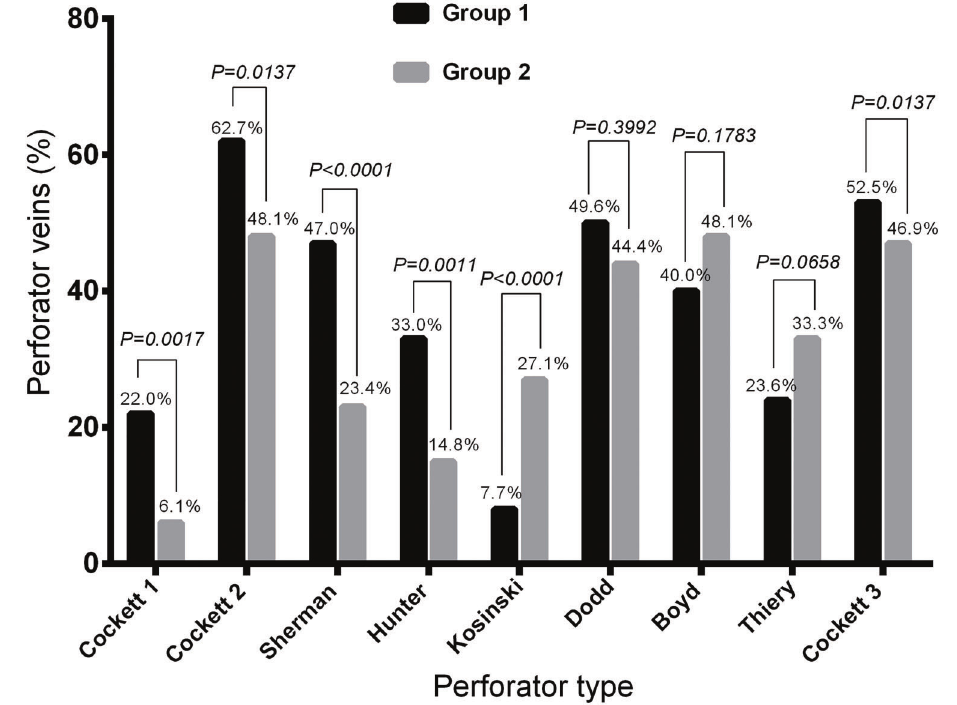
Figure 1. Anatomical distribution of the perforator veins. Data are reported as means ± SD. Group 1: truncal varicose veins: Group 2: diffuse varicose veins. Fisher ’ s exact test was used for statistical analyses.